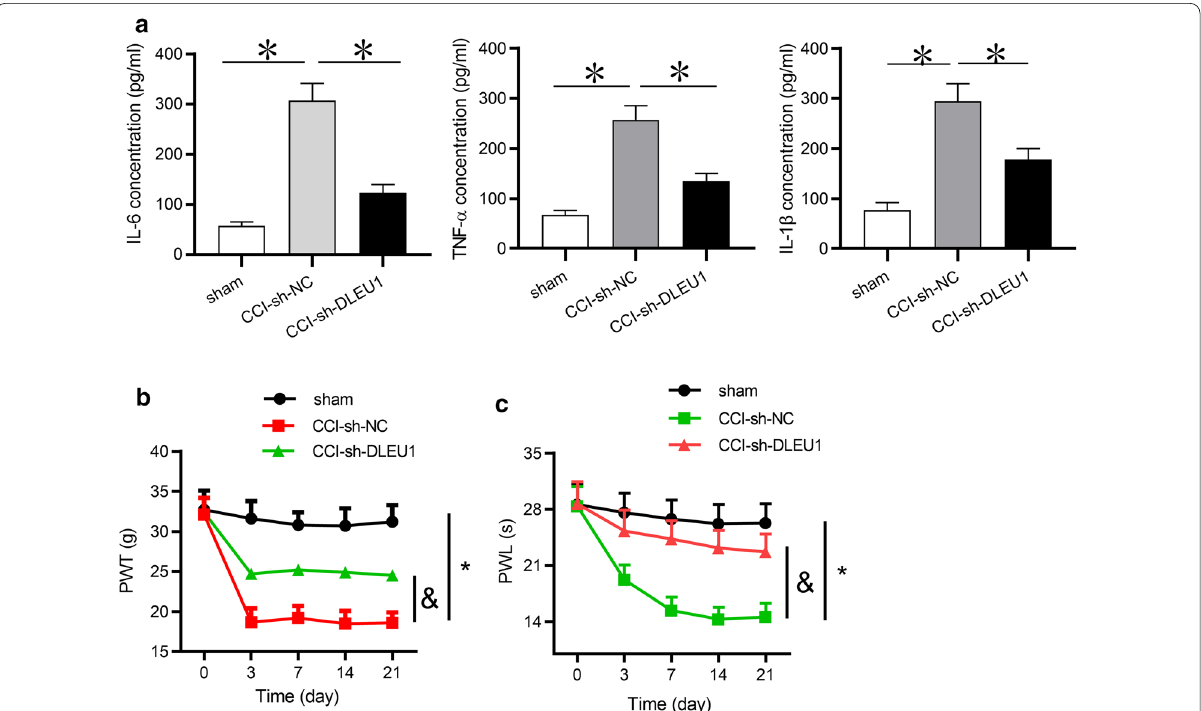
Fig. 2 DLEU1 knockdown suppressed neuroinflammation and attenuated neuropathic pain-like behaviors. a The concentrations of IL ‐ 6, TNF ‐ α and IL-1β in the dorsal spinal cord of rats were detected by ELISA at postoperative Day 7. N 8 for each group. b The effect of DLEU1 knockdown on = behavioral nociceptive responses to mechanical stimuli was assessed by paw withdrawal mechanical threshold (PWT) at postoperative days 0, 7, 14 and 21. N 8 for each group. c The effect of DLEU1 knockdown on behavioral nociceptive responses to thermal hypersensitivity was evaluated by = paw withdrawal latency (PWL) at postoperative days 0, 7, 14 and 21. N 8 for each group. *p < 0.05, & p < =